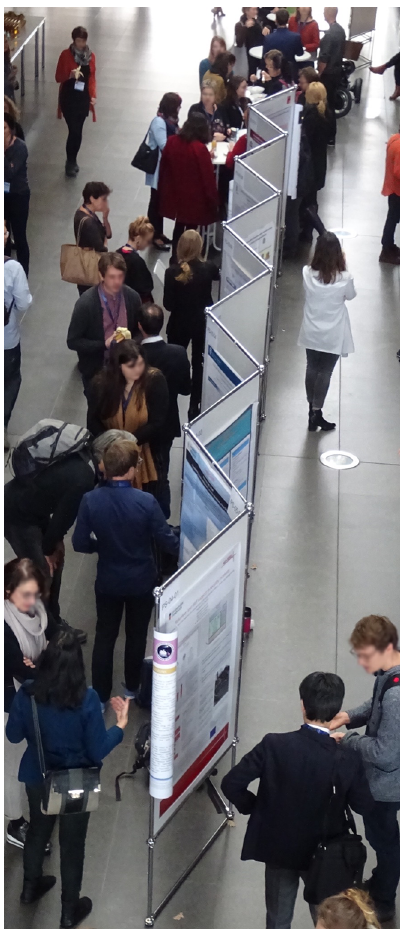
Figure 2. Postersession at the EACLIPT